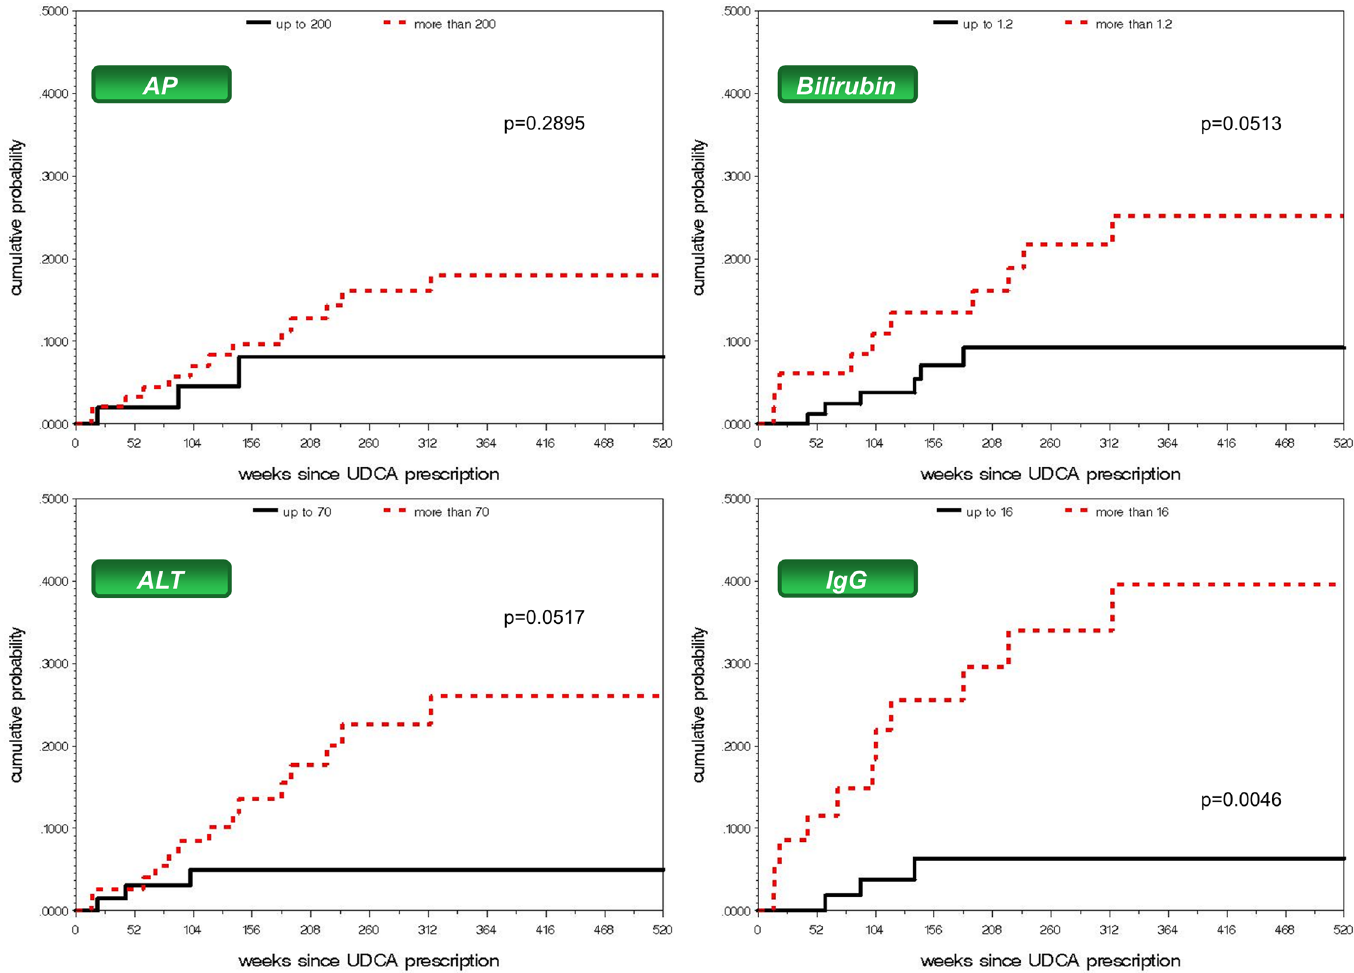
Fig 2. Cumulative probability of introduction of IT in the presence of competing risks at the time of PSC diagnosis (start of UDCA prescription): Alkaline phosphatase (AP), bilirubin, alanine aminotransferase (ALT), immunoglobulin G (IgG).